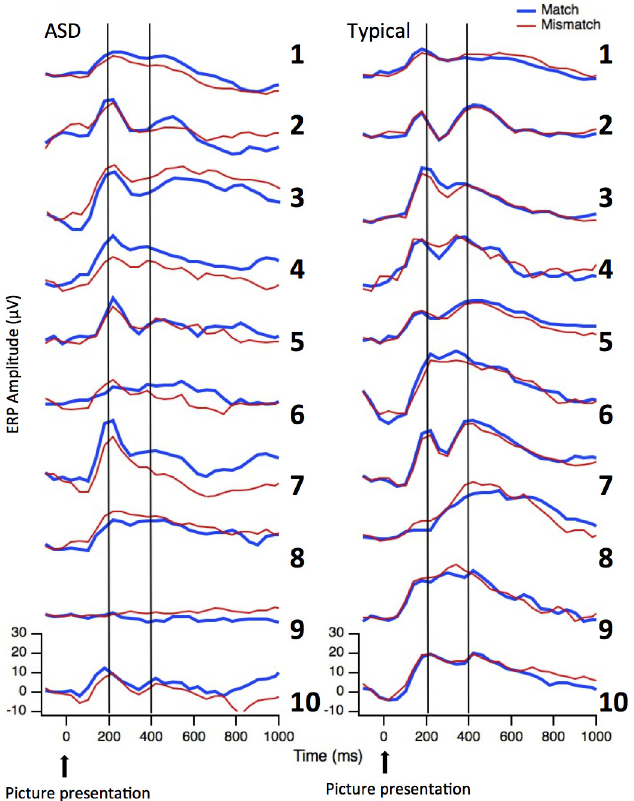
Fig 10. Individual ERP profiles for Visual Evoked Potentials. Individual ERP waveforms time-locked to the picture for the two groups (ASD children on the left and Neurotypical children on the right) and the two conditions (Match in blue and Mismatch in red) in the Occipital array. Vertical lines indicate the expected latency for the two peaks associated with basic visual processing: P1 and PSW.